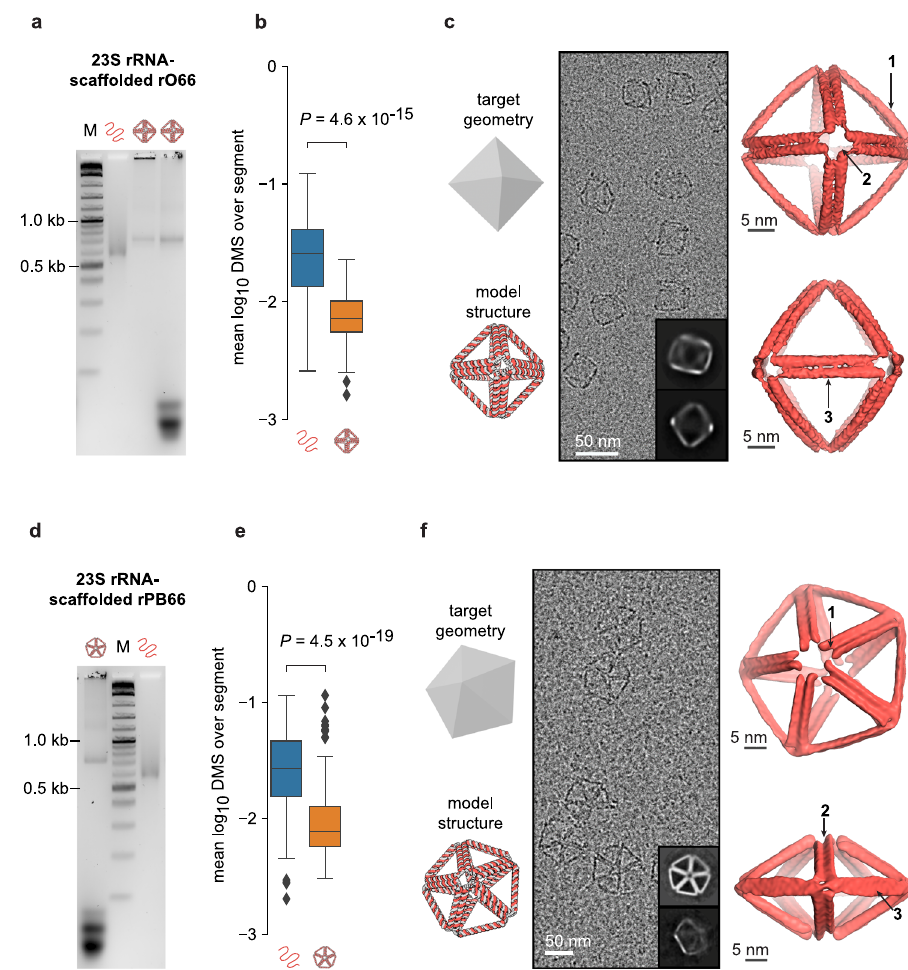
Fig. 3 | Characterization of 23S rRNA-scaffolded origami. a Gel mobility shift assay,lefttoright:marker(1kbplusDNAladder,NEB),23SrRNAfragmentscaffold without DNA staples, spin fi lter-puri fi ed folded rO66, and unpuri fi ed folded rO66, n =1 replicate. b Box plots showing, for each unbroken segment of RNA:DNA duplex in rO66 ( n =134 segments) the mean DMS reactivity among adenines and cytosines in the segment ’ s RNA scaffold strand (right, orange) compared with the same adenines and cytosines in the RNA strand folded without DNA staples (left, blue), n =1 replicate each. Each box plot depicts the median (middle line), 1st and 3rd quartiles (box), minimum/maximum up to 1.5 interquartile ranges from box (whiskers),and outliers (grey diamonds).Each P -value indicates the signi fi cance of thedifferencebetweentheleftandrightdistributions(two-sidedWilcoxonsigned- rank test). c The input target geometryand predictedDX wireframe atomic model